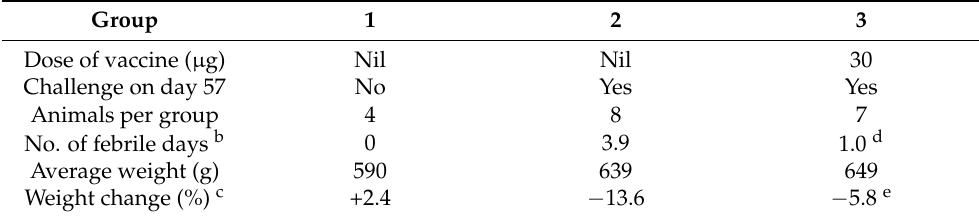
Table 3. Protection induced by Vaccine A a measured by febrile response and weight change. Group 1 Dose of vaccine ( µ